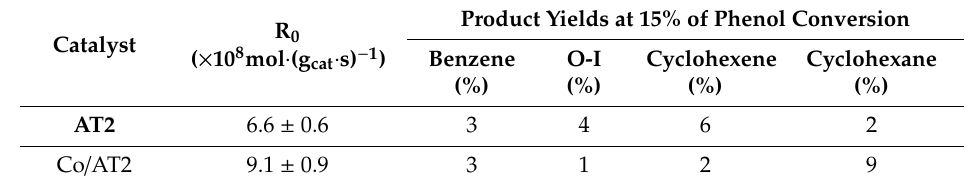
Table 1. Initial reaction rate of the HDO of phenol at 5.5 MPa and 593 K and product yields at 15% of the conversion for AT2 support and Co/AT2 sulfided catalyst.